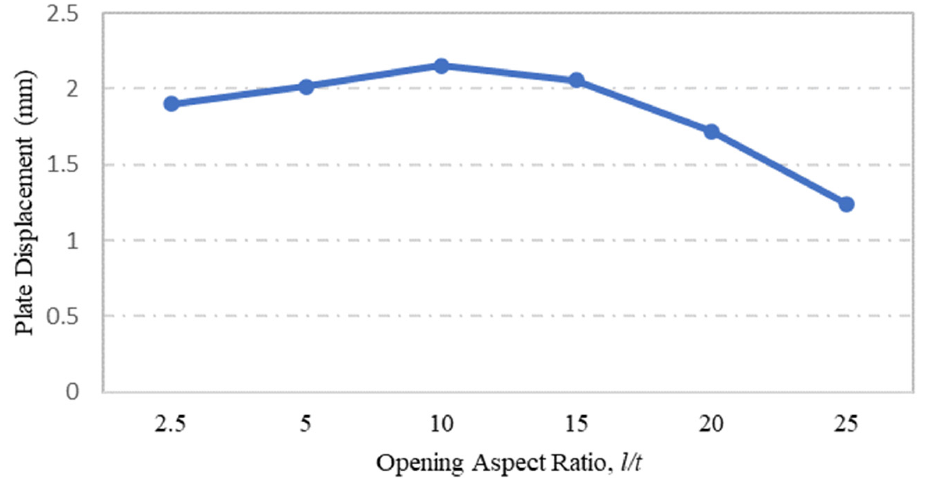
Figure 13. Influence of plate opening aspect ratio on maximum displacement.